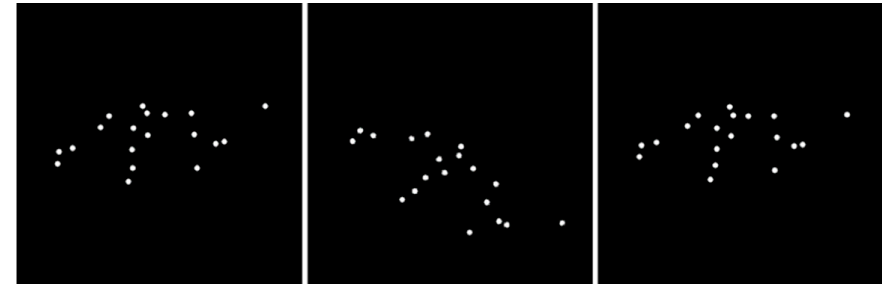
Figure 4. Examples of U-Net output masks.